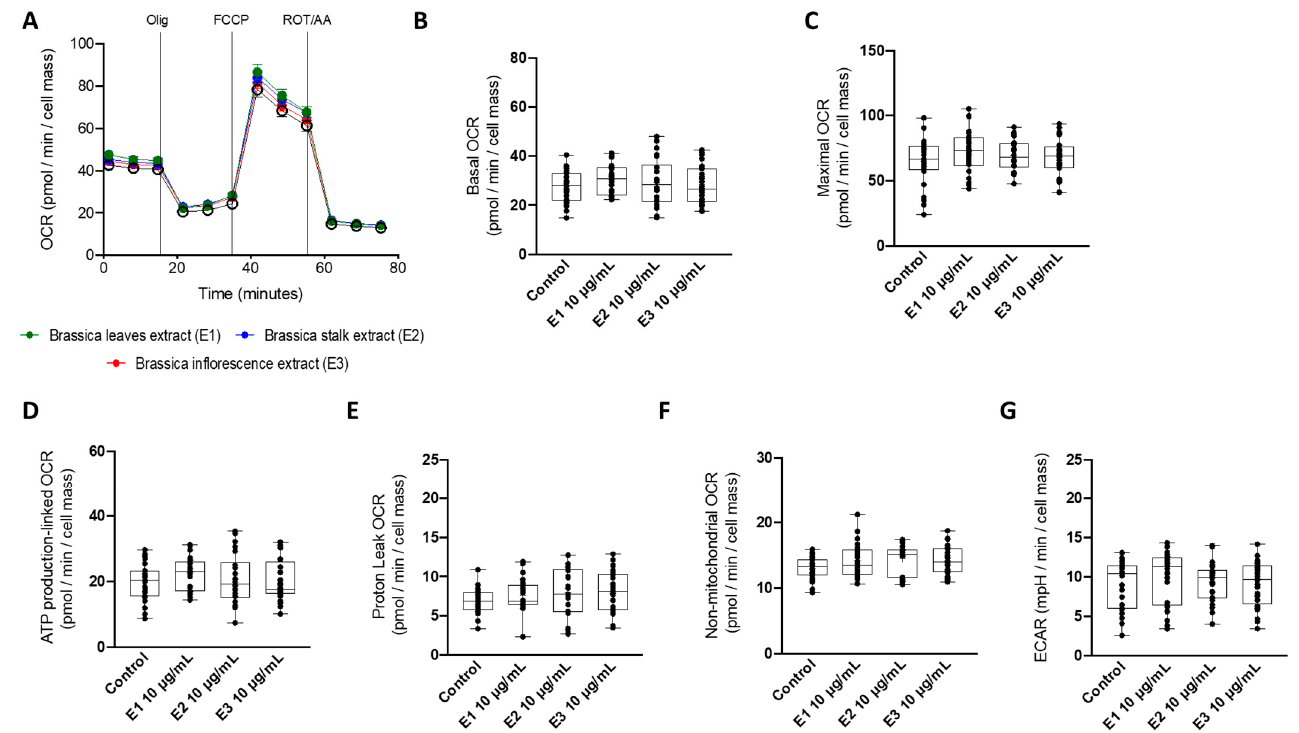
Figure 2. Effect of broccoli extracts on mitochondrial function of HepG2 cells. ( A ) Representative image of oxygen consumption rate (OCR) measurement in HepG2 cells treated with vehicle (CTL) or leaf (E1—green), stalk (E2—blue), or inflorescence (E3—red) Brassica extracts for 48 h. Several OCR parameters were evaluated: ( B ) cellular basal OCR; ( C ) maximal OCR; ( D ) ATP-production- linked OCR; ( E ) proton-leak-linked OCR; ( F ) non-mitochondrial OCR; and ( G ) basal extracellular acidification (ECAR). Data are the mean ± SEM of 3 independent experiments, and the results are expressed as pmol O 2 /min/cell mass for OCR and mpH/min/cell mass for ECAR. The data obtained with BBP extracts were compared to CTL using a one-way ANOVA with Dunnett’s multiple comparison